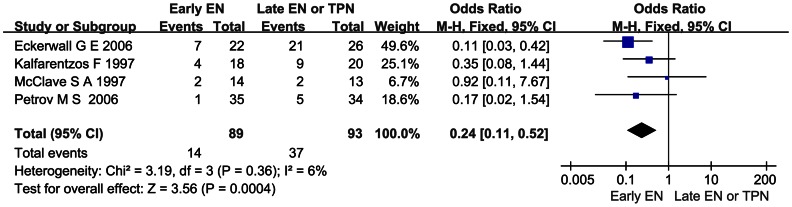
Forest plot showing the effect of early EN on the incidence of hyperglycemia in AP.Fixed-effect model was applied.